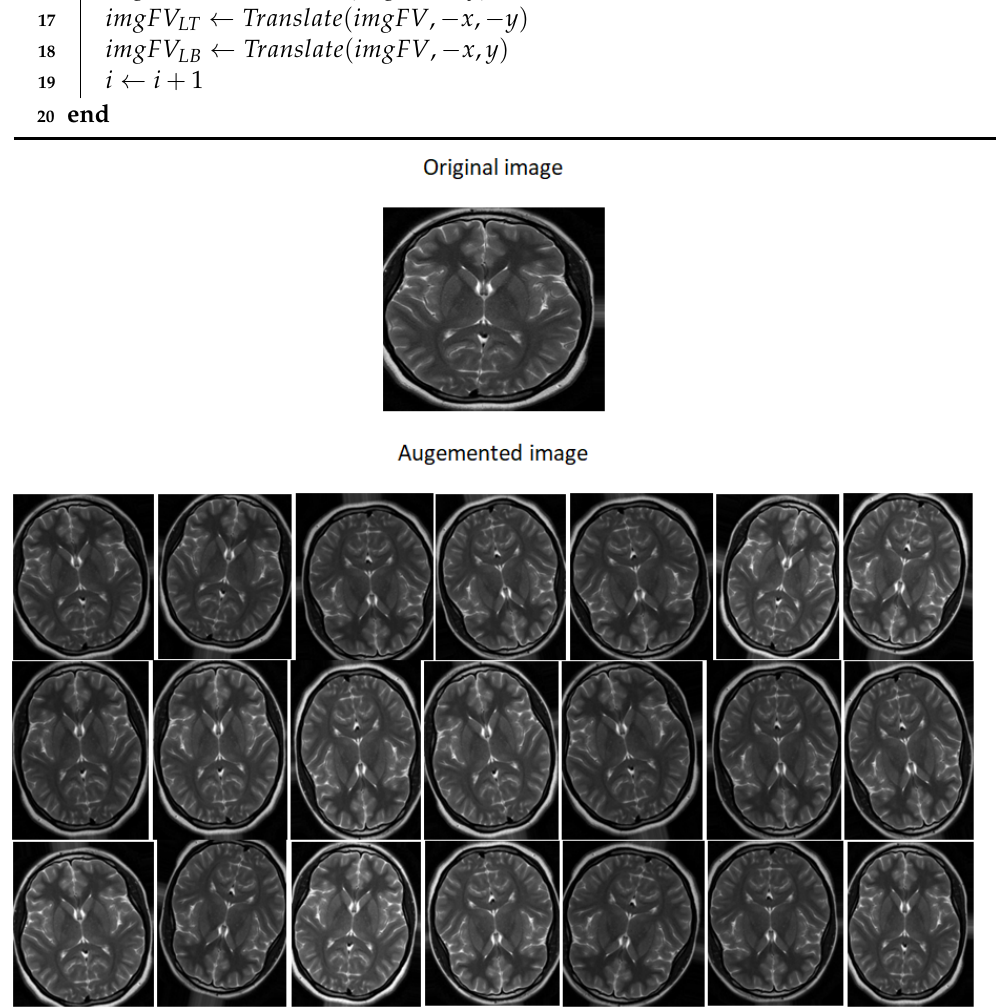
Figure 6. Database